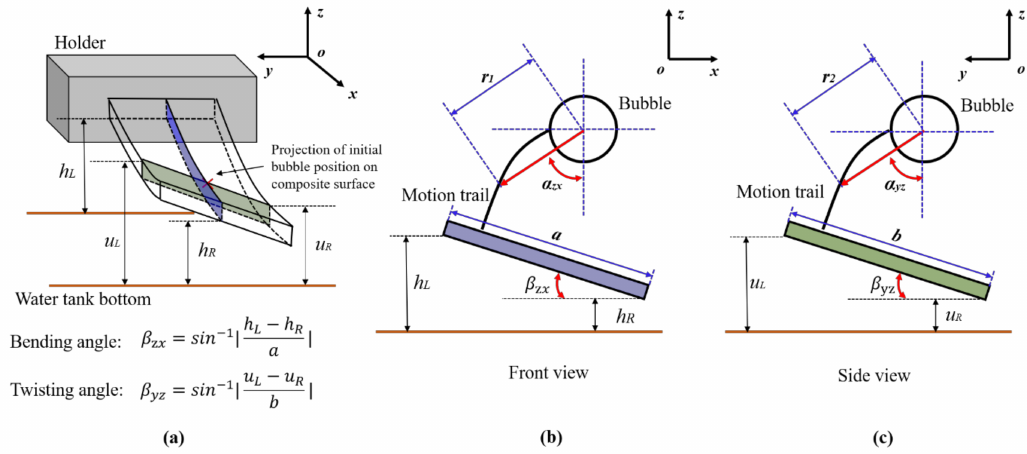
Figure 8. Schematic diagram of bubble trajectory and composite beam response: ( a ) 3D schematic diagram of bending and twisting angle definition; ( b ) bending angle of composite beam and bubble trajectory parameters, ( c ) twisting angle of composite beam and bubble trajectory